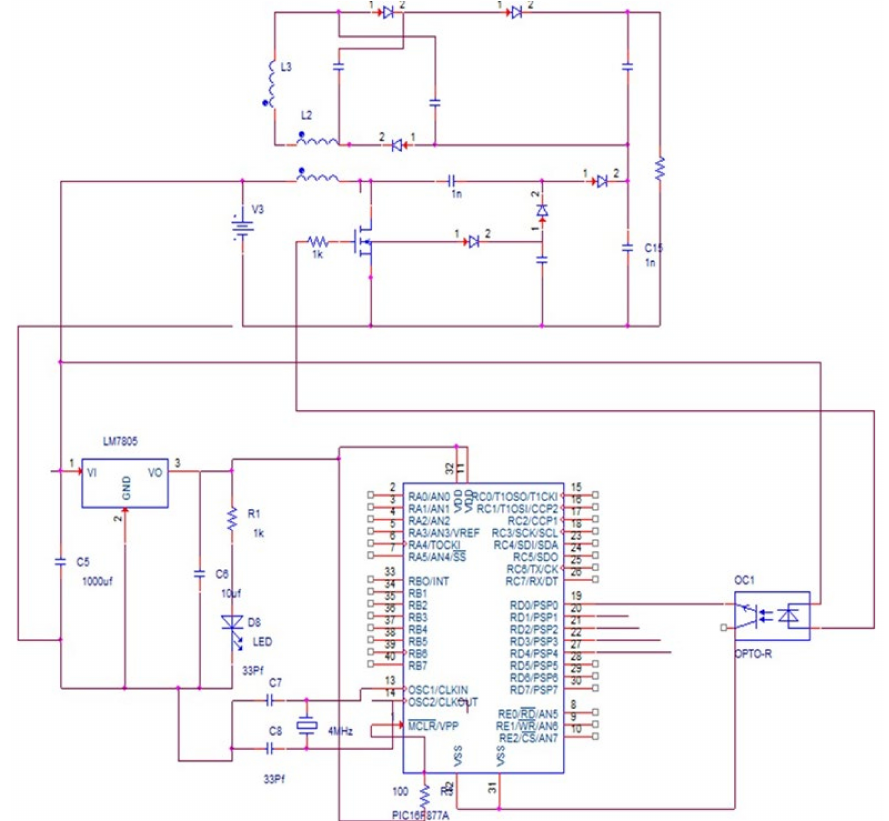
Figure 8. Hardware